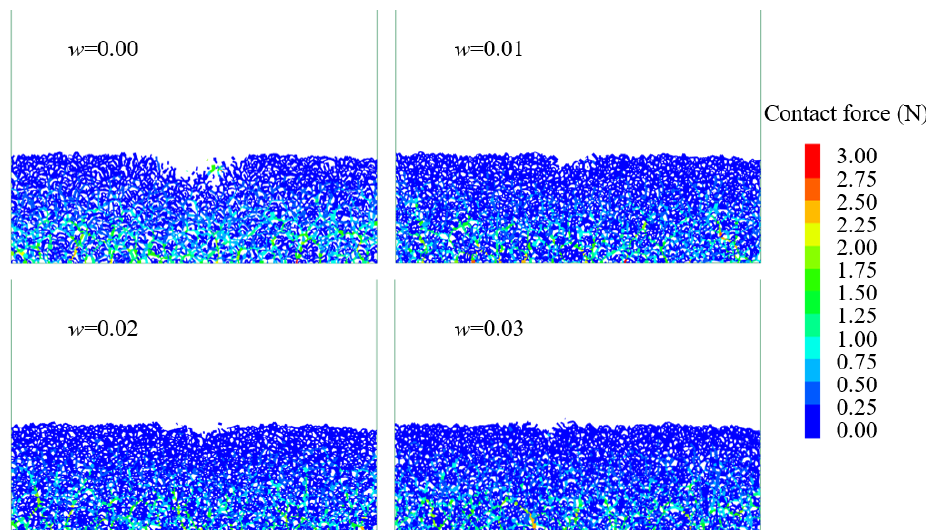
Figure 5. The distribution of contact forces among sand grains in sand-bed collision under different surface moisture in times of 0.15 s ( V in = 5m/s). Contact forces are represented as lines and the colour indicates magnitudes of